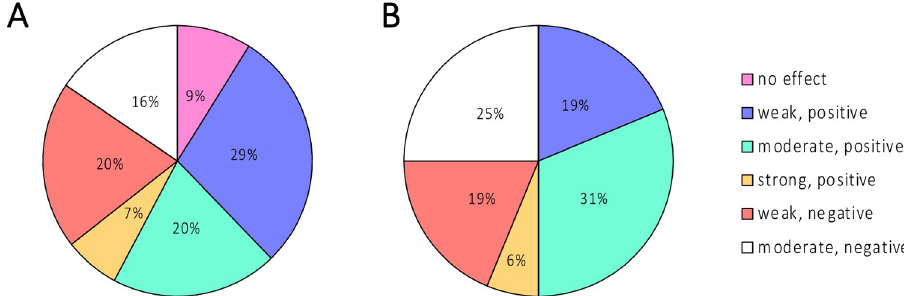
Fig 5. Effect of co-colonizing CoNS on S . aureus biofilm biomass in co-culture biofilms in (A) cases and (B) controls. The effect was calculated based on log 2 fold change from S . aureus mono-species biofilm biomass. Effect on biofilm biomass was arbitrarily classified based on log 2 fold change as follows: “no effect” ( > -0.1 to < 0.1); “weak, positive” (0.1 to < 0.4); “moderate, positive” (0.4 to < 0.9); “strong, positive” ( > 0.9); “weak, negative” (-0.1 to < -0.4); “moderate, negative” (-0.4 to <